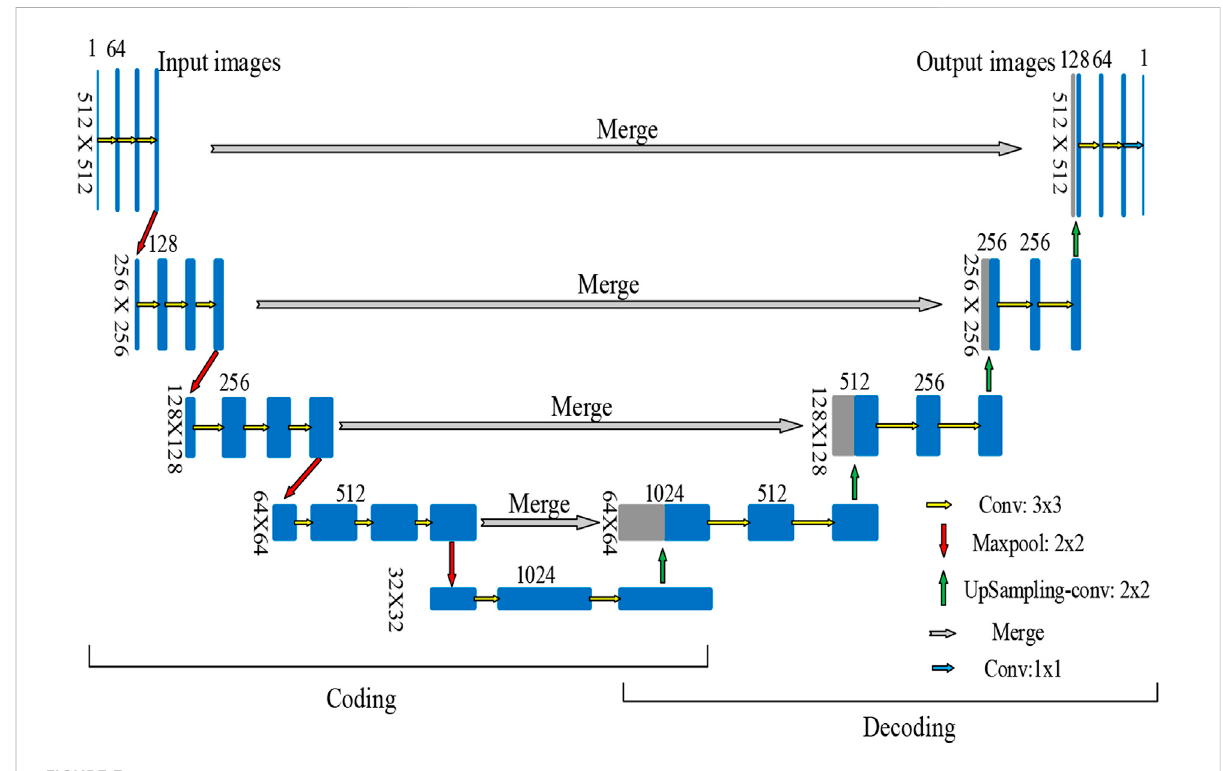
FIGURE 3 The structure of our U-Net network.